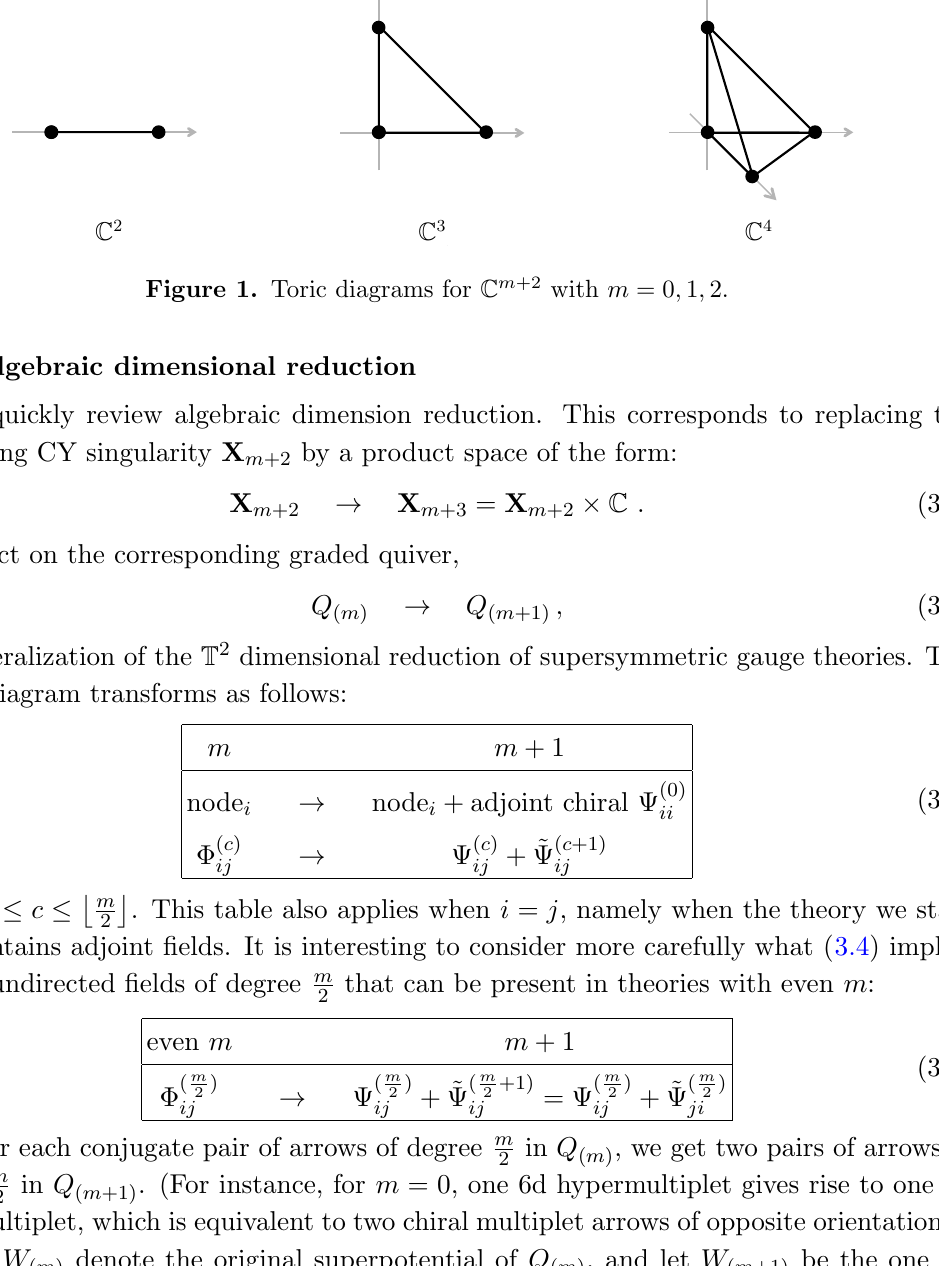
Figure 2 . Toric diagrams for F ( m )